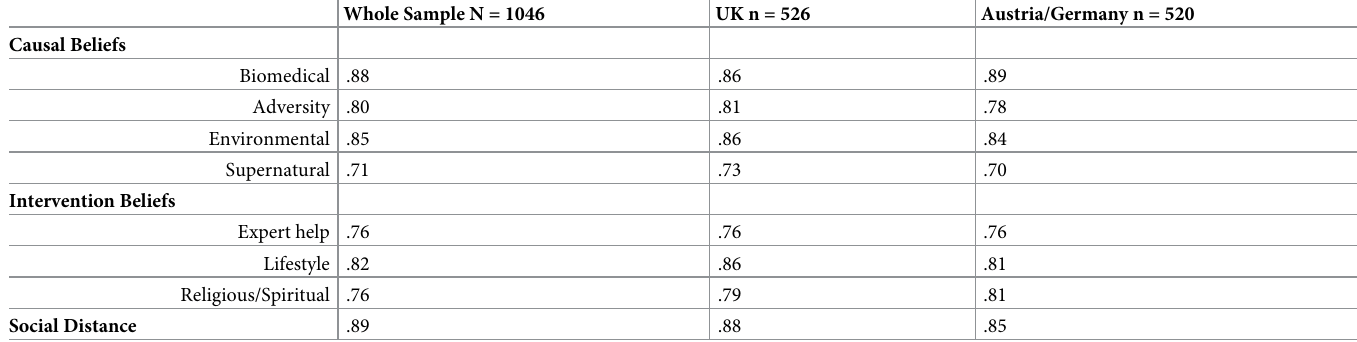
Table 3. Cronbach’s alphas for all scales and